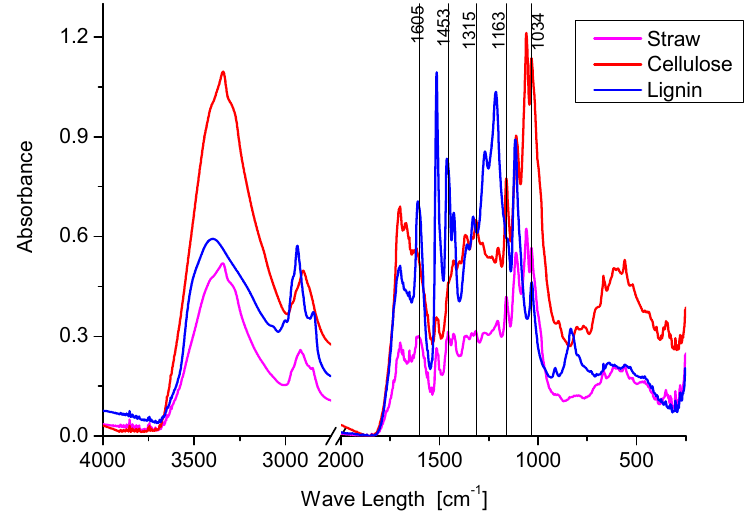
Figure 9. FTIR spectra of hydrochars from straw, cellulose, and lignin. HTC conditions: 220 °C, 10% DM (Dry Mater), 4 h reaction time (Modified from [21]).